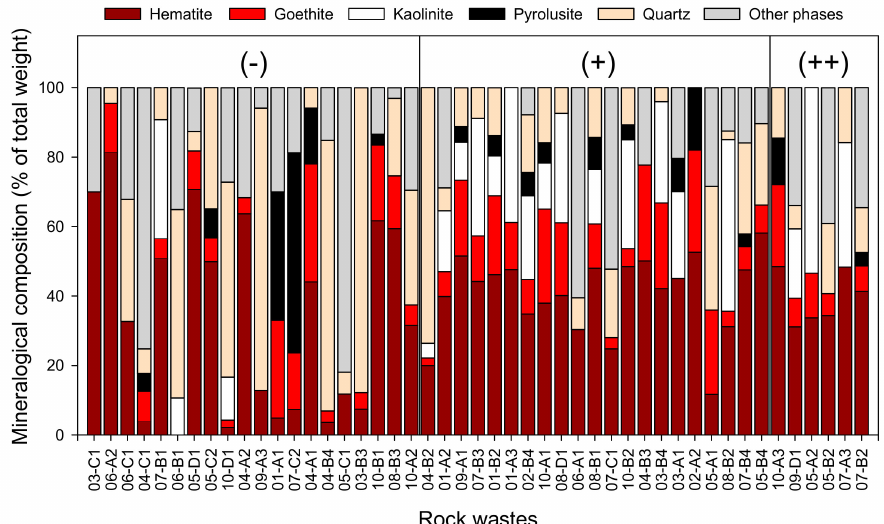
Figure 3. Mineralogical composition of sampled rock wastes (i.e., not suitable (-), suitable ( + ), and promising ( ++ ) for As removal), ordered by increasing As adsorption potential (from left to right). Mineralogical phases occurring in less than 30% of the samples were grouped and plotted as “other